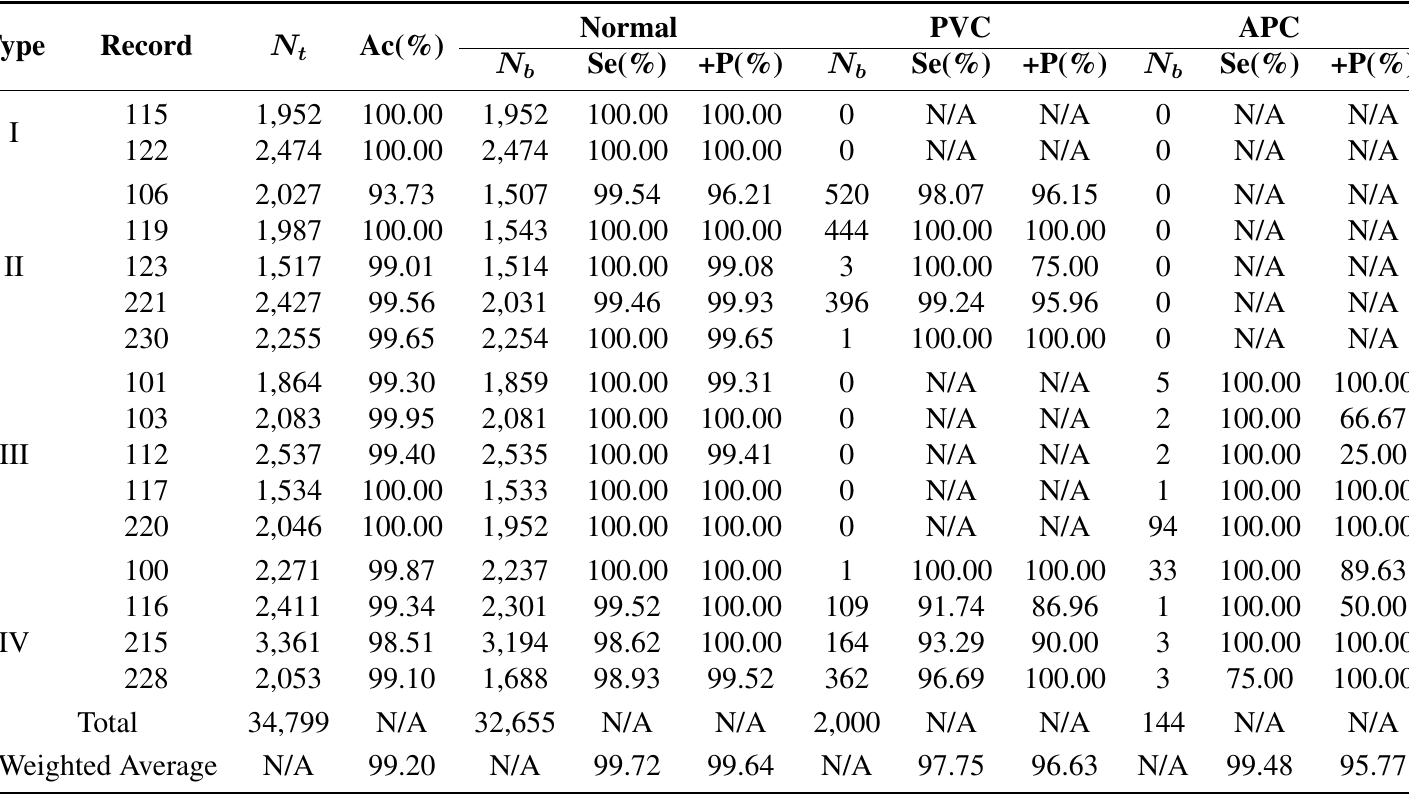
denotes the number of b